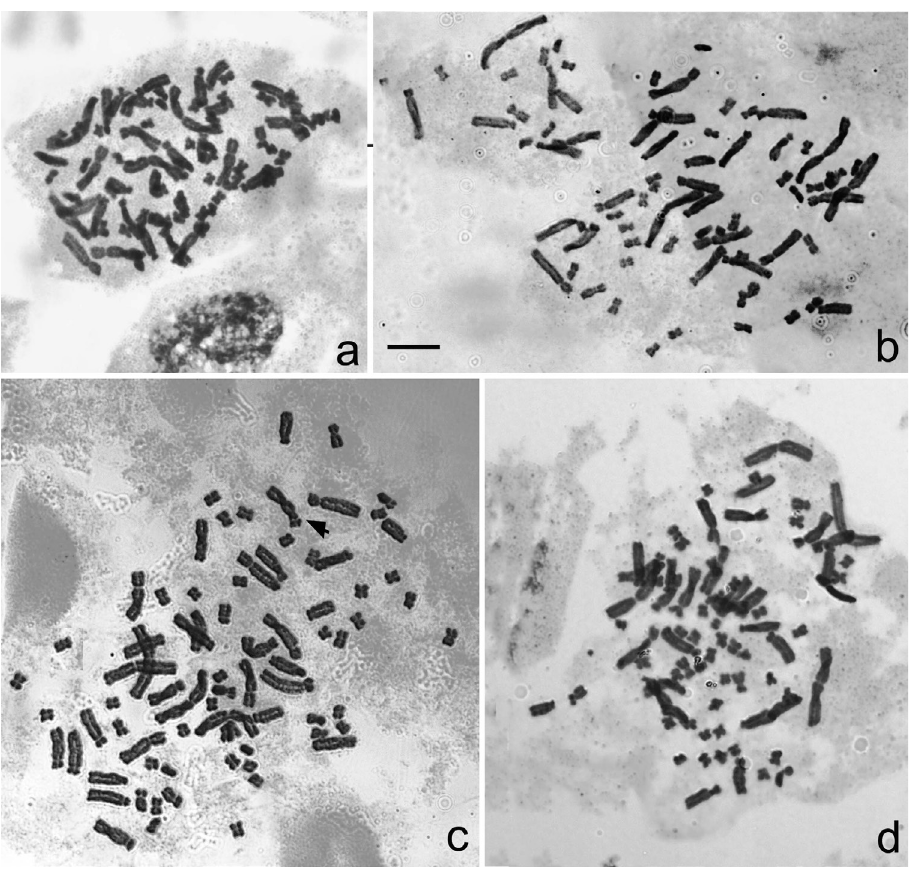
Figure 1. Somatic Chromosome at mitotic metaphase in Aspidistra subrotata of 2n = 76. a Jilong popula- tion b 5th boundary marker population c Nonggang National Nature Reserve population, and the arrow shows the secondary constriction of the chromosome d 4th boundary marker population. Bar = 10